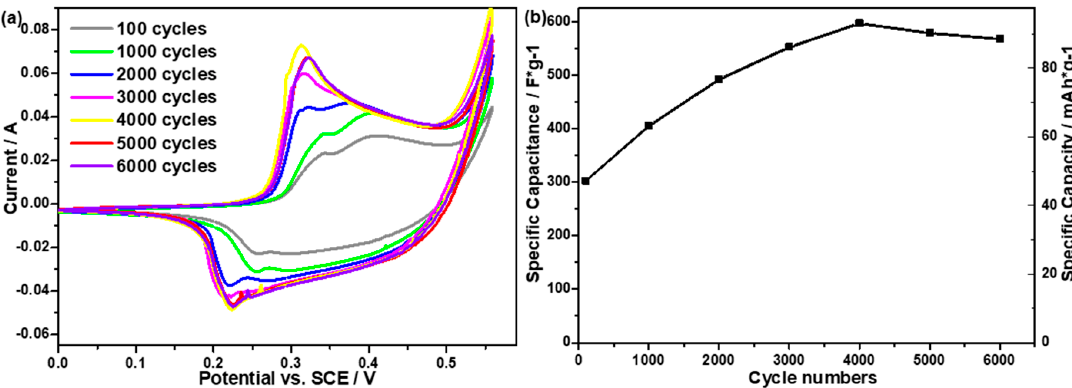
Figure 7. ( a ) CV curves of CoAl LDH-PANI electrode at different scan cycles. ( b ) Specific capacitance and specific capacity values (obtained from CV curves) of CoAl LDH-PANI electrode as a function of cycle numbers. (scan rate 20 mV/s).